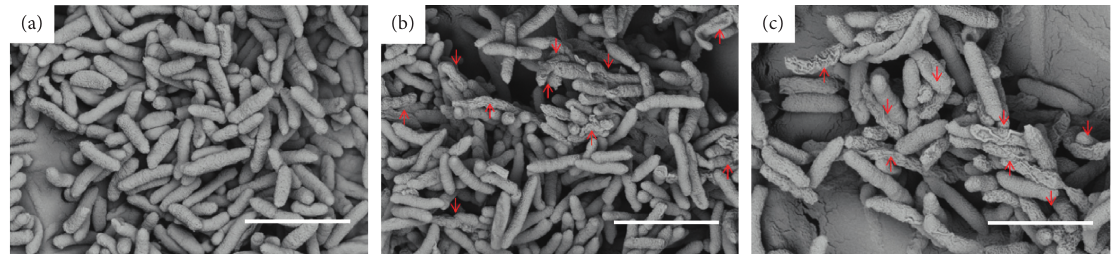
Figure 5: SEM images of Xoo after incubation with different concentrations of compound 3l : (a) 0 μ g/mL and (b, c) 14 μ g/mL; scale bars for (a-b) are 3 μ m and scale bar for (c) is 2 μ m. Table 3: Inhibition rates of 3a–3o against two fungal strains at 25.0 µ g/mL.